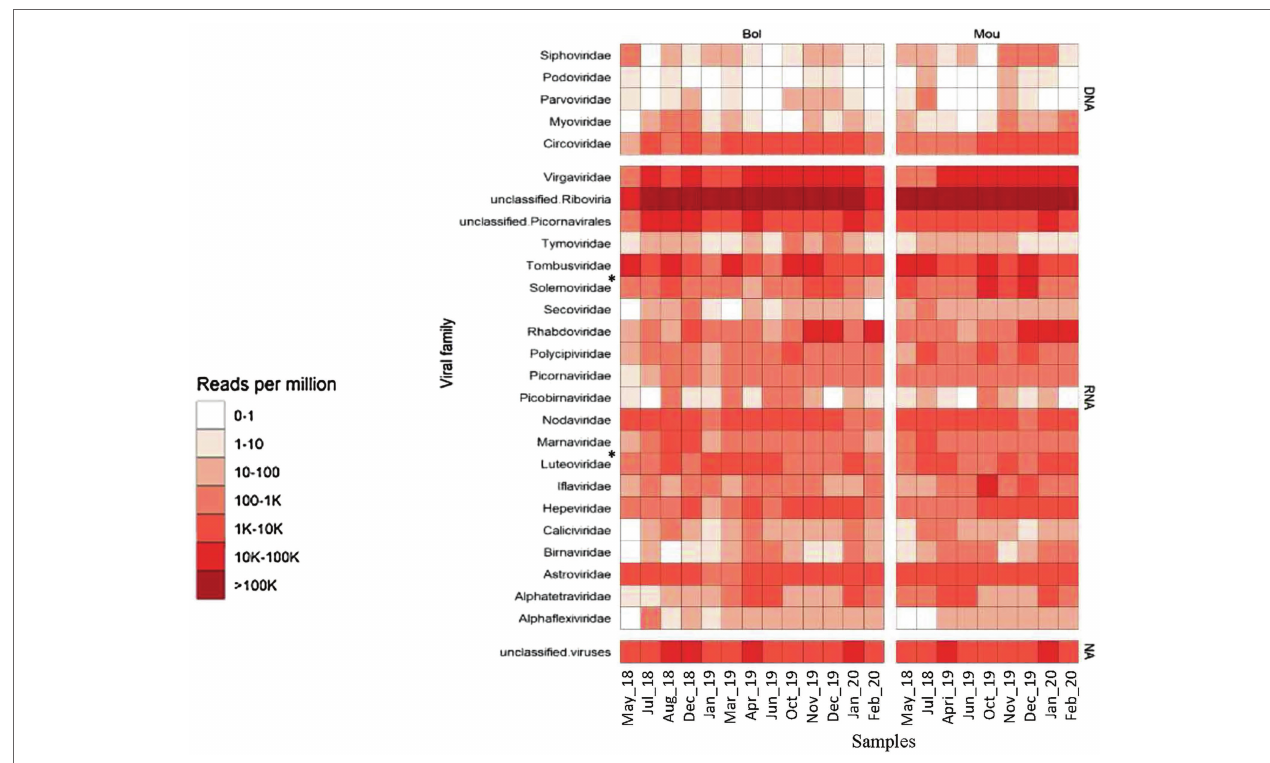
FIGURE 3 | Heatmap of the viral diversity. The read abundance after quality control and deduplication is presented for the two sites (Bol and Mou). Color gradients represent normalized relative abundance of reads expressed in reads per million (RPM) for each sample belonging to taxonomic groups indicated, with the top five rows corresponding to DNA viruses, the last row to unclassified viruses and middle rows to RNA viruses. *Since 2021, Luteoviridae was assigned to Solemoviridae .